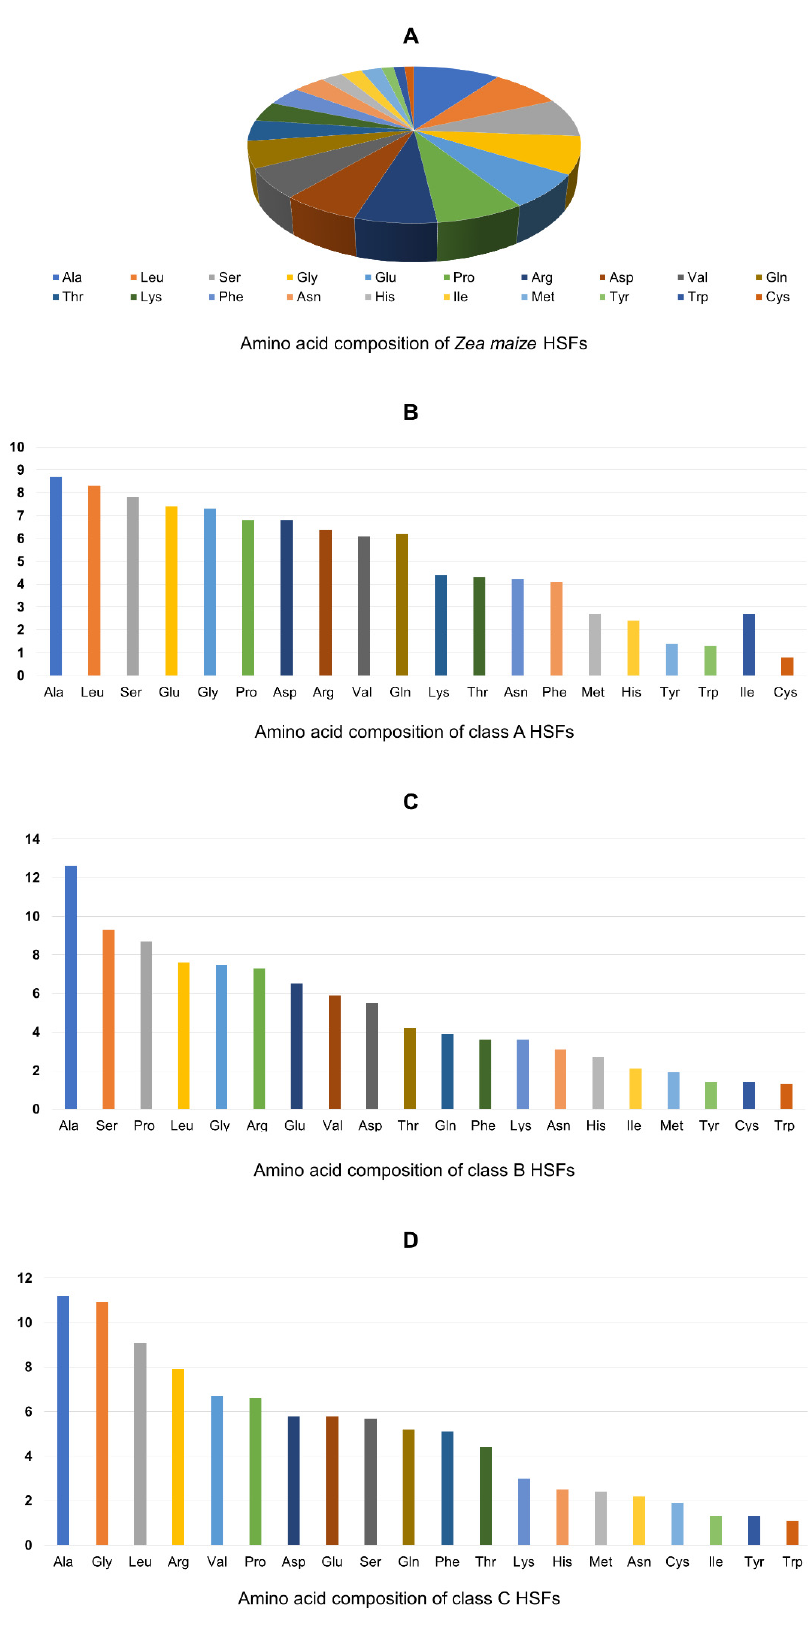
Figure 7. ( A ) The overall amino acid composition of maize HSFs, ( B ) class A HSFs, ( C ) class B HSFs, and ( D ) class C HSFs.